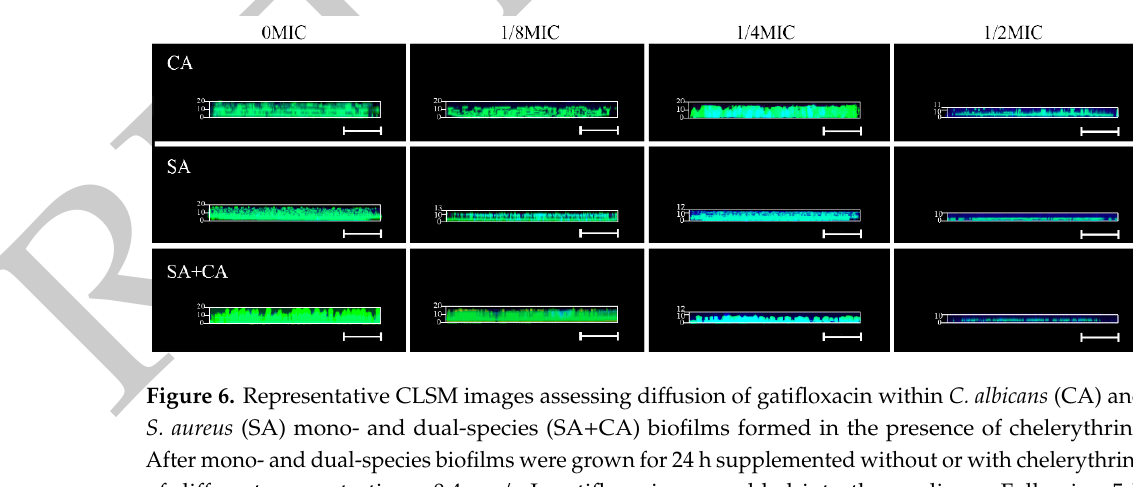
Figure 6. Representative CLSM images assessing diffusion of gatifloxacin within C. albicans (CA) and S. aureus (SA) mono- and dual-species (SA+CA) biofilms formed in the presence of chelerythrine. After mono- and dual-species biofilms were grown for 24 h supplemented without or with chelerythrine of different concentrations, 0.4 mg/mL gatifloxacin was added into the medium. Following 5 h gatifloxacin diffusion, the biofilms were visualized using CLSM. Biofilms were stained with SYTO 9 for biofilms (green) and the intrinsic fluorescence of gatifloxacin (blue). Scale bars represent 10 μ m.